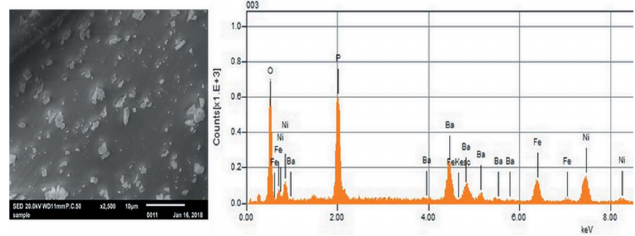
Figure 5 Polyhedral representation of the crystal structure of BaNi 2 Fe(PO 4 ) 3 showing Ba1 and Ba2 in the channels.